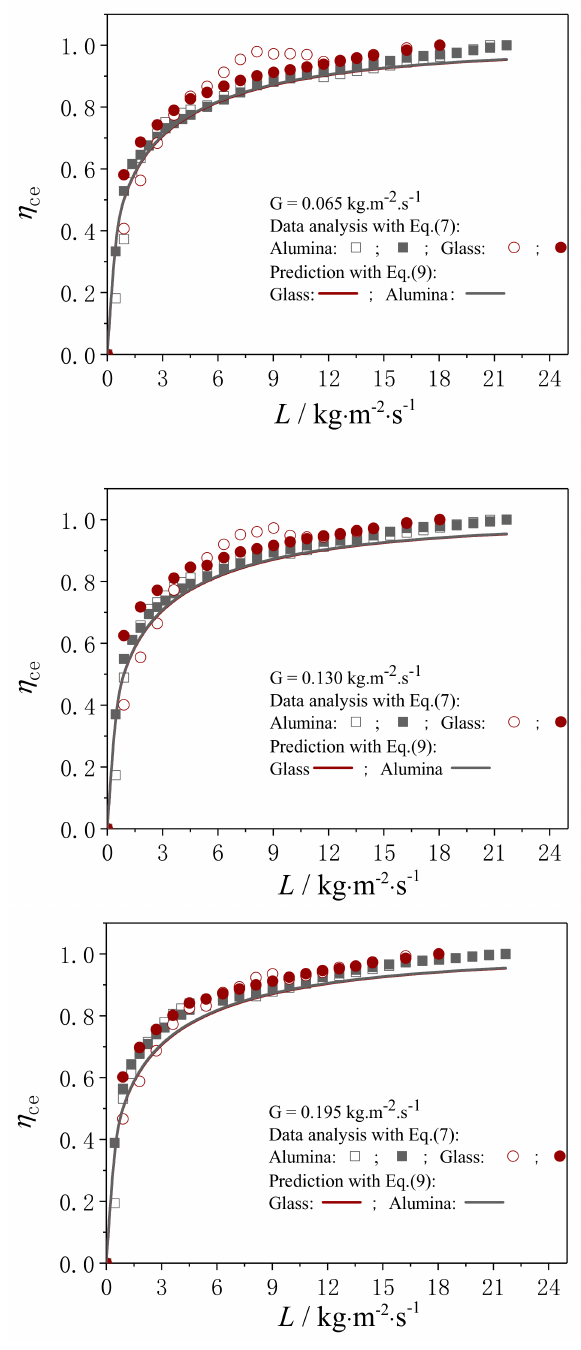
Figure 8. Prediction of liquid–solid wetting